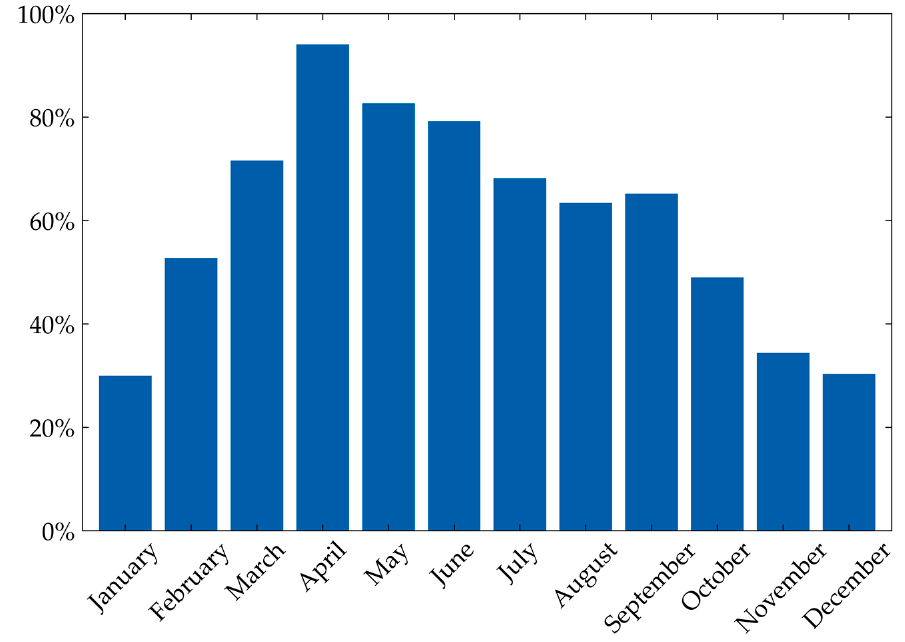
Figure 10. PV electricity load coverage per month after the renovation of the Welsh site room.